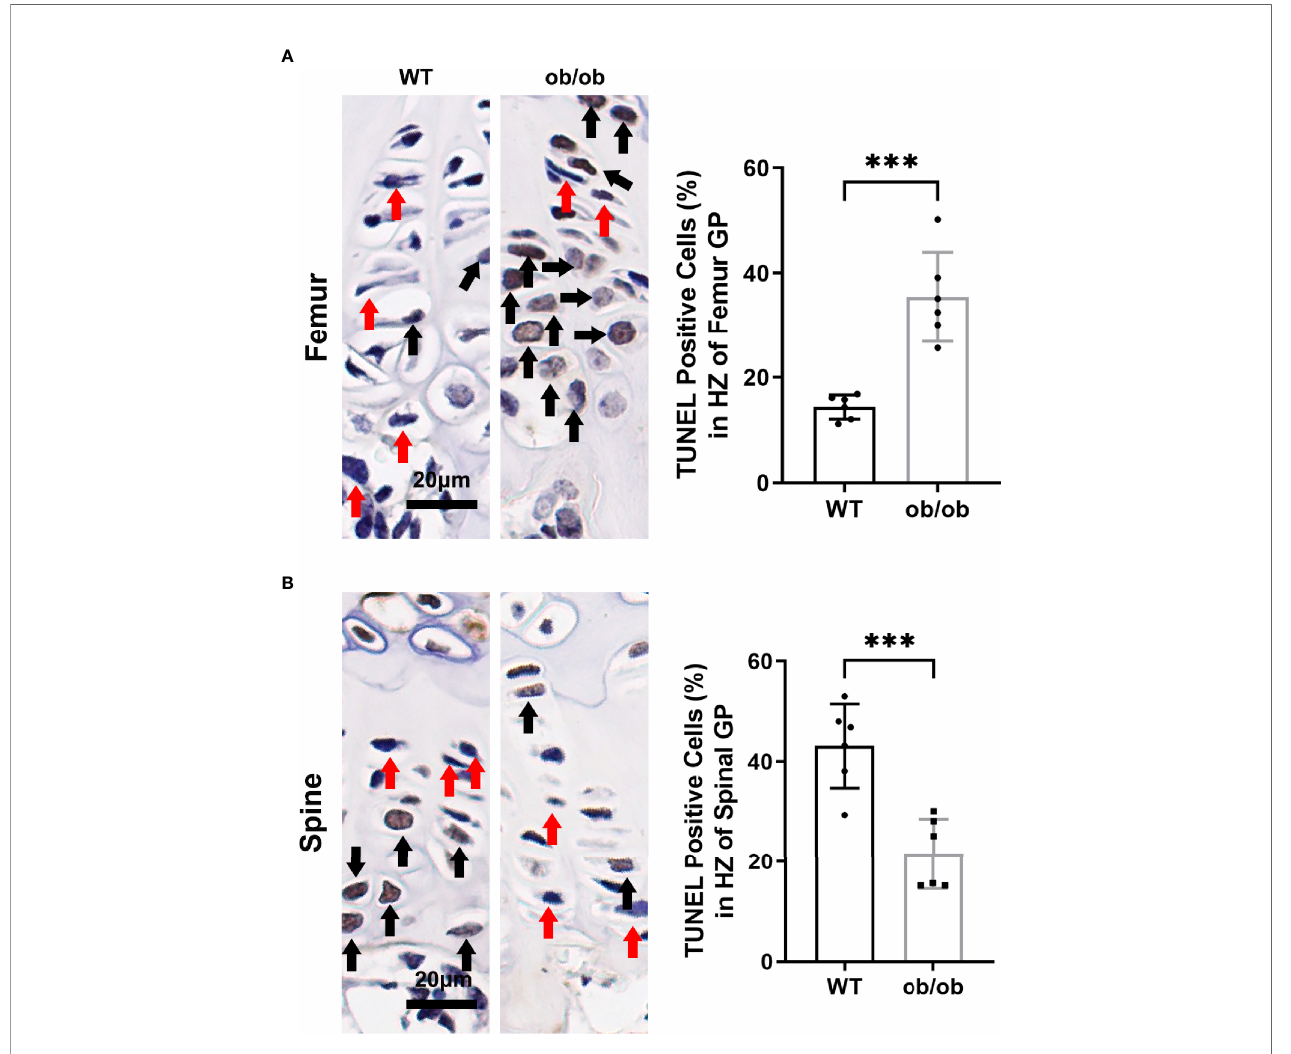
FIGURE 3 | Comparison of femur (A) and spinal (B) growth plate apoptosis between wild type mice and ob/ob mice using TUNEL method, and percentages of positive cells were calculated. Black arrow determines the positive cell, and red arrow determines negative cell. Scale bar: 20 m m; n=6 in each group, *** P <